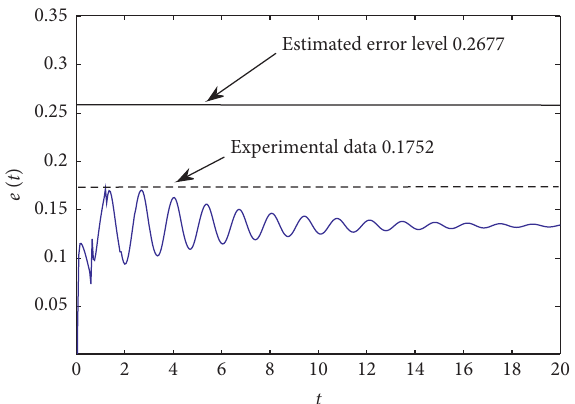
Figure 2: The synchronization error ‖ e ( t )‖ when μ